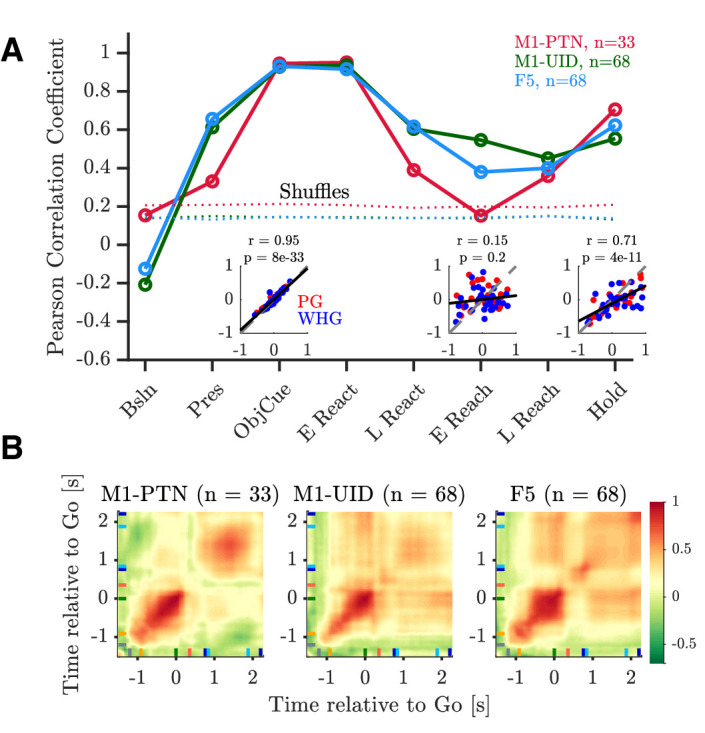
Relationship between execution and observation activity.Pearson correlation coefficients of execution and observation activity shown for each epoch and MN sub-population. Dotted lines represent 95th percentiles of null distribution calculated via shuffling neurons. Insets show net normalized activity during execution and observation in M1-PTNs during Object Cue, Early Reach, and Hold epochs. PG and WHG are shown in red and blue, respectively, correlations are calculated across both grasps.